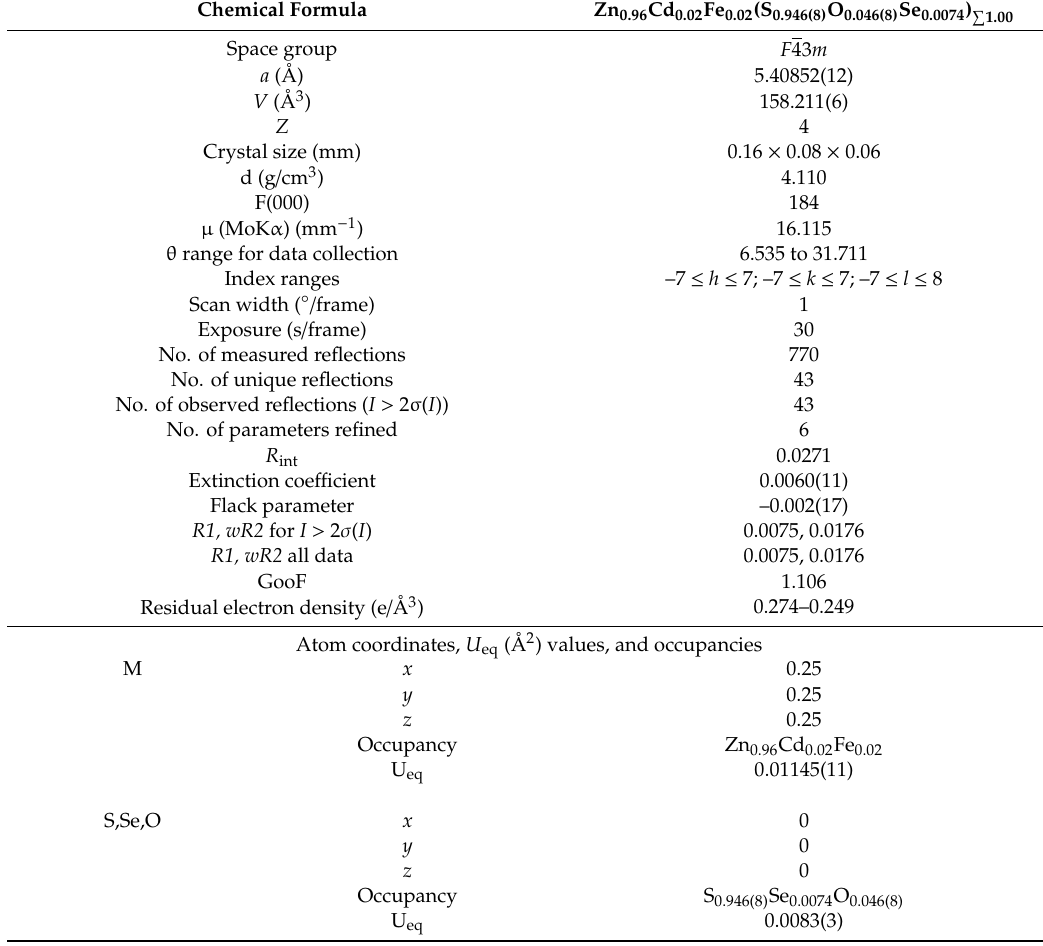
Table 12. Crystal parameters, data collection and structure refinement details for Fe-, Cd-, Se-, O-bearing